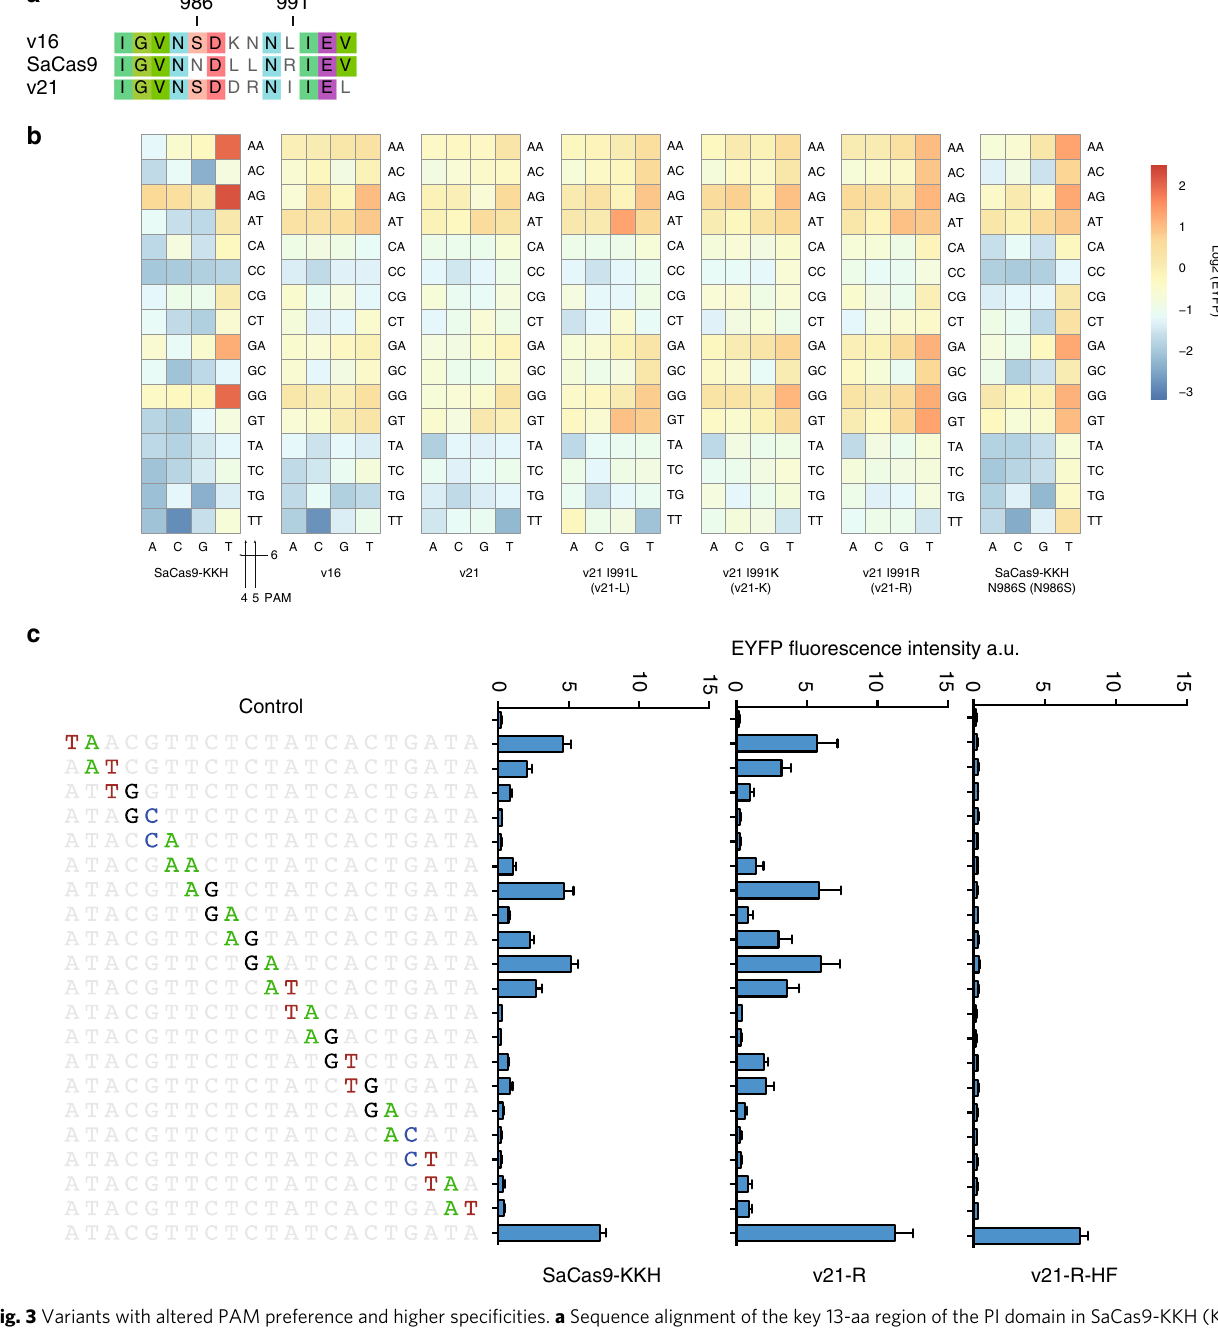
Fig. 3 Variants with altered PAM preference and higher speci fi cities. a Sequence alignment of the key 13-aa region of the PI domain in SaCas9-KKH (KKH), cCas9 v16 and v21. b Functional characterization of SaCas9 variants at CCCNNN PAMs. Schematic of the EYFP reconstitution assay is shown in Fig. 1c. Data indicated the mean ( n = 3 independent biologic replicates) activities of indicated cCas9 variants and SaCas9-KKH. c Cleavage activities of SaCas9- KKH (KKH), cCas9 v21-R, and v21-R-HF (containing R499A, Q500K, R654A, and G655R mutations) at on-target and off-targets with dinucleotide mutations were evaluated by using the EYFP reconstitution assay. All targets contained a CCCAGT PAM. Bars represented the mean (± s.e.m., n = 3) of EYFP fl uorescent intensity measured by using fl ow cytometer 3 days after transfection into HEK293FT cells. Source data are provided as a Source Data fi